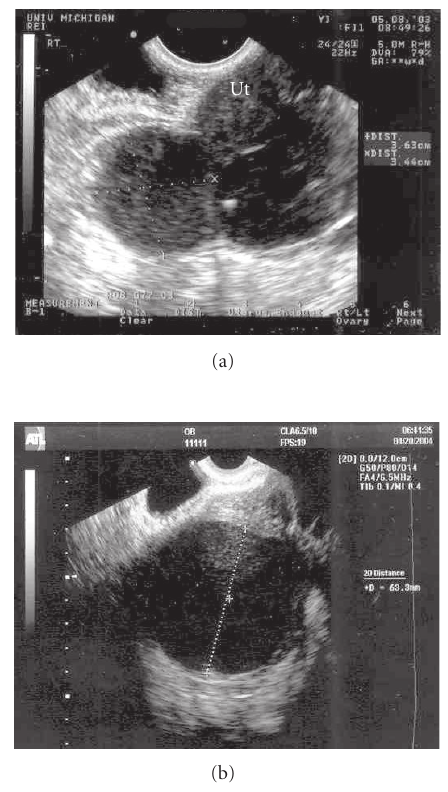
Figure 1: (a) Transvaginal ultrasound image, shortly after initial evaluation, of persistent bilateral ovarian masses adjacent to uterus (Ut). (b) Ultrasound image of left ovarian cystic structure after pa- tient presented with symptoms of acute pelvic inflammatory dis- ease.